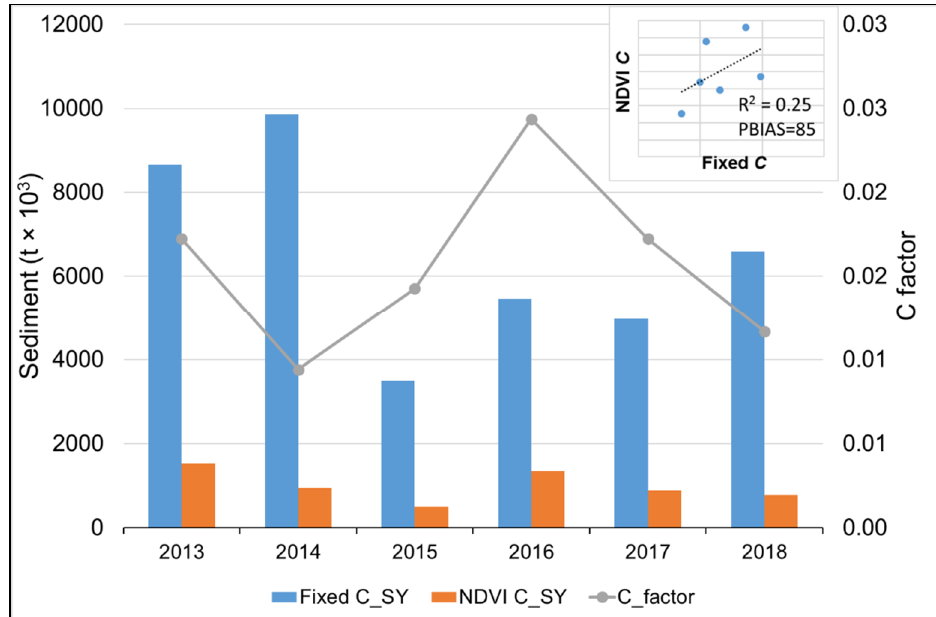
Figure 7. Sediment yield (SY) variation resulting from the fixed and variable (NDVI) C factor.